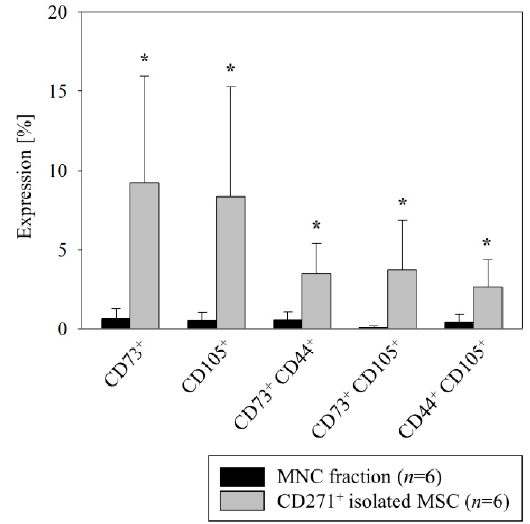
Figure 2. Flow cytometric analysis of MACS-isolated human BM CD271 + stem cells. The freshly isolated BM derived CD271 + stem cells showed a mesenchymal identity by a predominant expression of CD73 and CD105 MSC markers as compared with the entire MNC fraction. Mean ± SD, * p ≤ 0.015 (Mann–Whitney U Test).